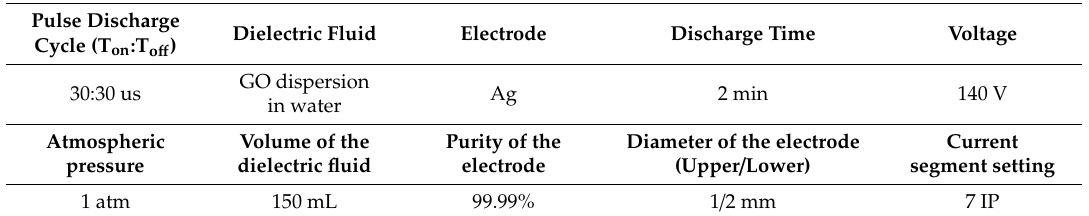
Current segment